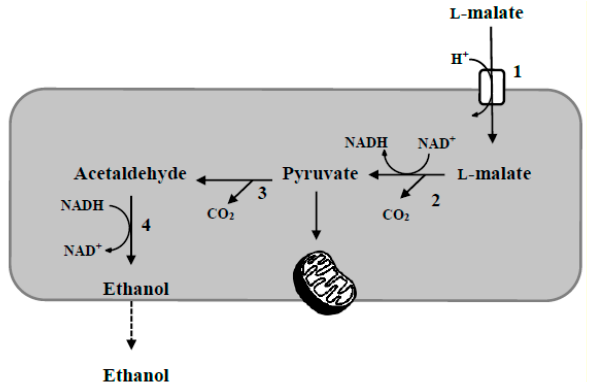
Figure 2. Schematic representation of malic acid degradation by Schizosaccharomyces pombe